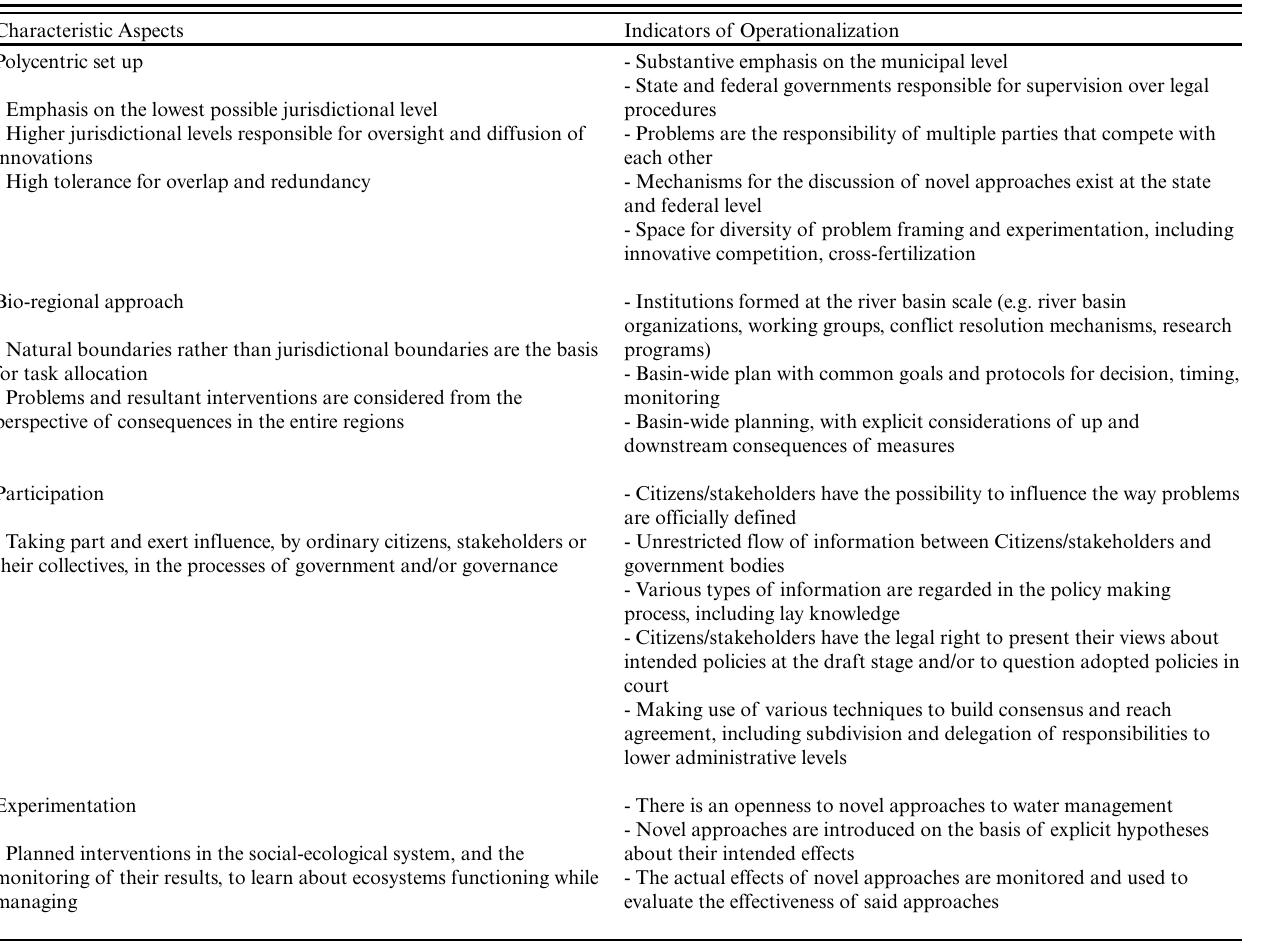
Table 1 . Characteristic aspects of adaptive comanagement (ACM) prescriptions and indicators of